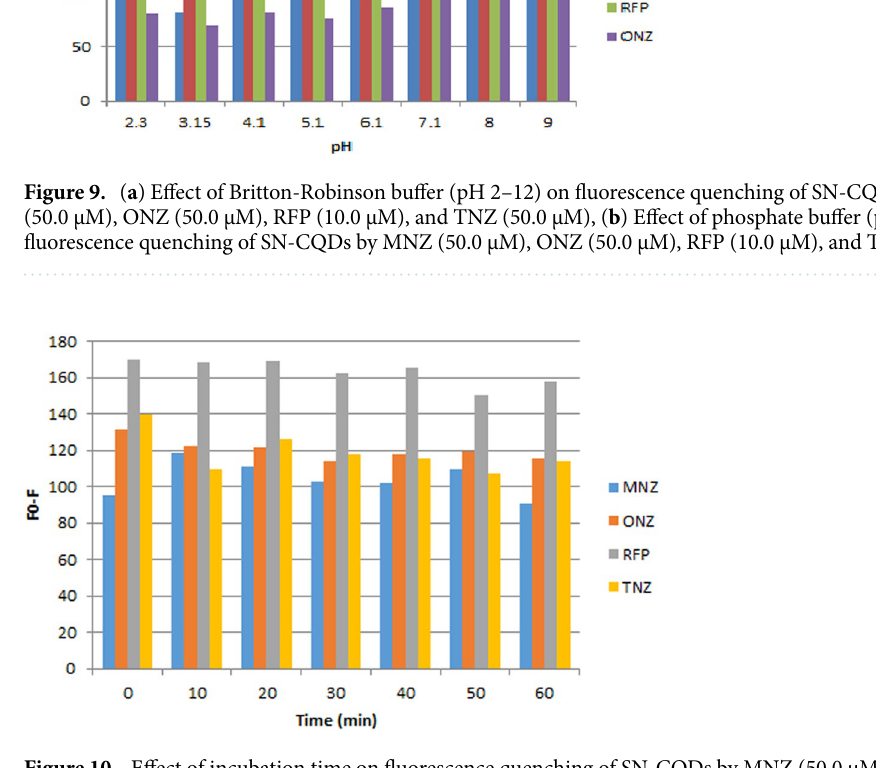
Figure 10. Effect of incubation time on fluorescence quenching of SN-CQDs by MNZ (50.0 μM), ONZ (50.0 μM), RFP (10.0 μM), and TNZ (50.0